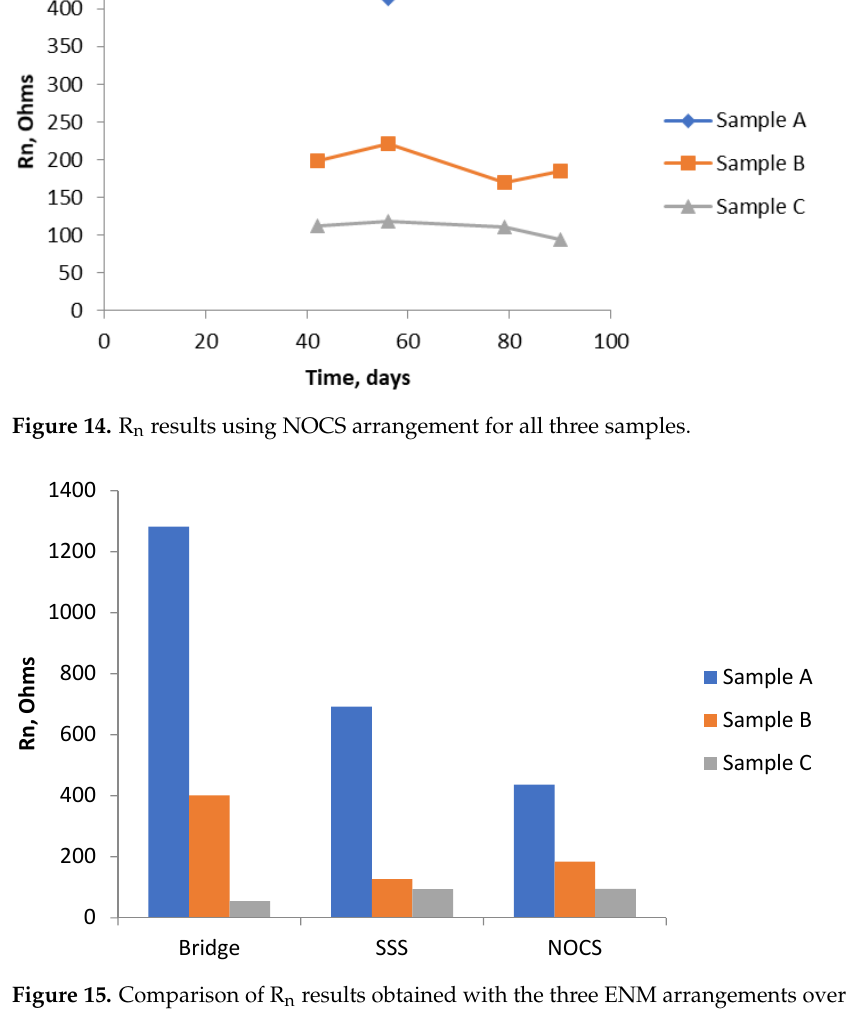
Table 2. Average Rn value over whole test period